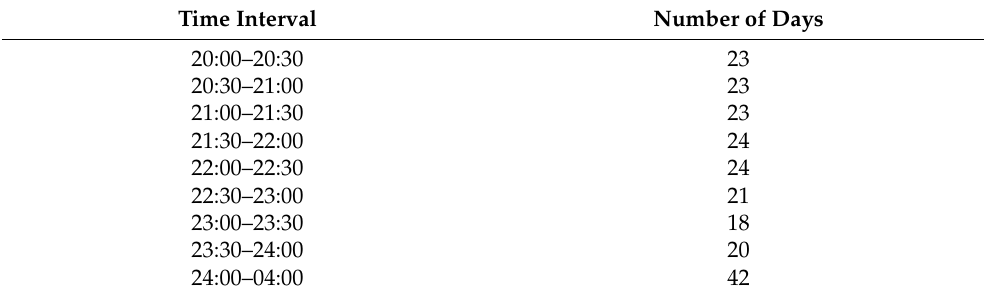
Table 2. Number of days of cloudless and moonless SQM records series from 1 November 2019 to 12 April 2020. Due to cloud and moon interference, the length and members of the dates vary during different time intervals.